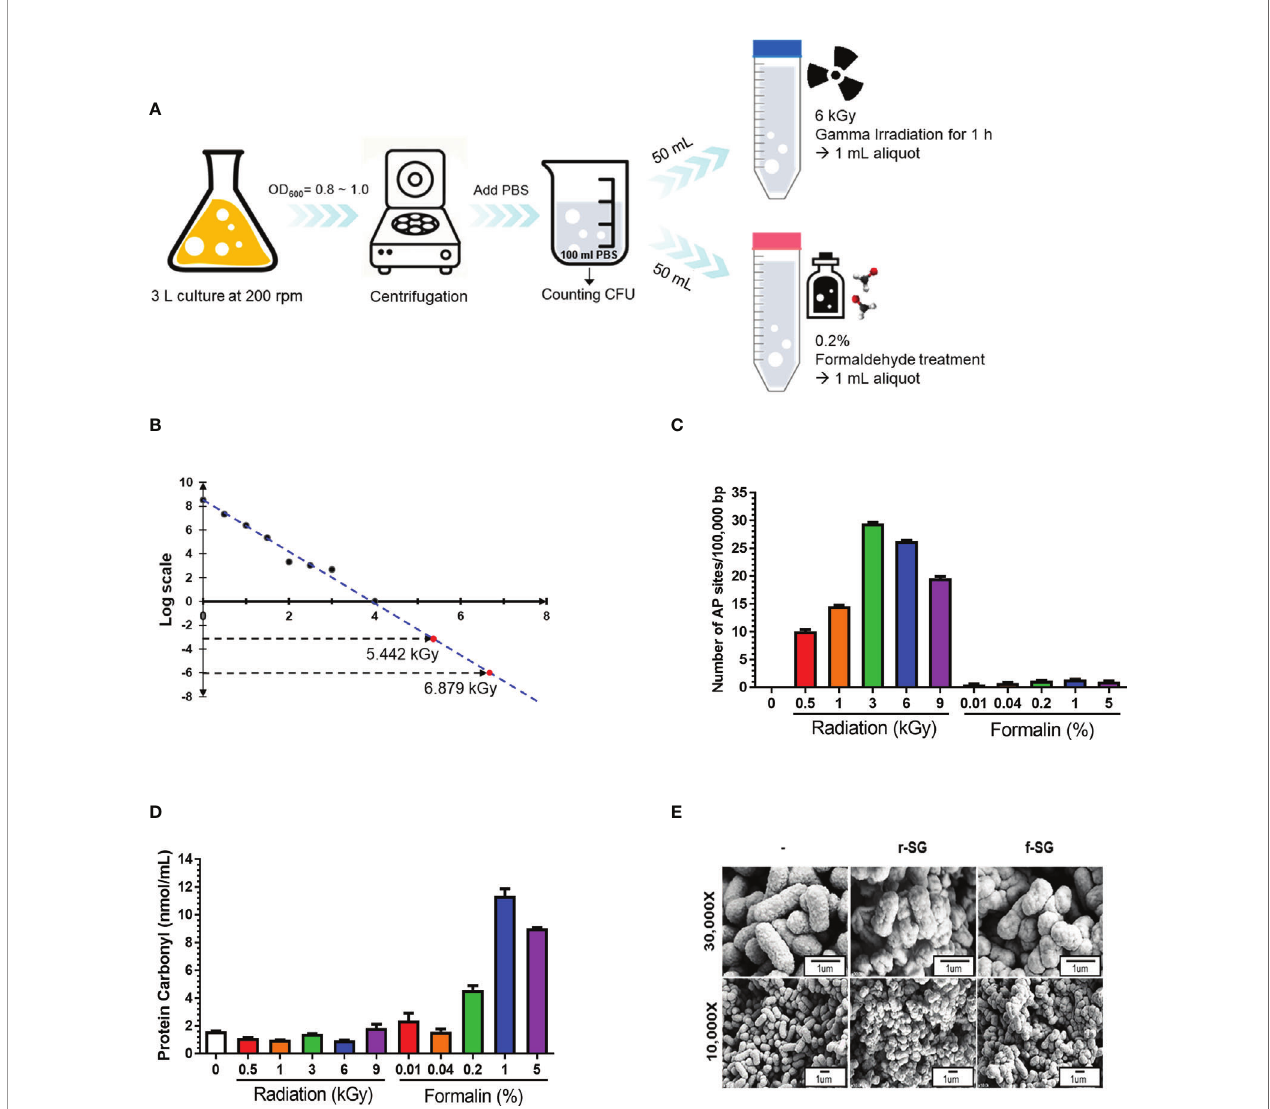
FIGURE 1 | Production and characterization of inactivated SG vaccines. (A) Schematic procedure for r-SG and f-SG vaccine production. (B) Radiation-inactivated vaccine was produced according to the ‘ Sterility Assurance Level (SAL). ’ SG was harvested and re-suspended in PBS and irradiated with the indicated dose of gamma radiation ( 60 Co gamma-ray source) and plated on LB agar to count the number of surviving bacteria. No SG was detected in samples irradiated with doses of gamma radiation >3 kGy. (C) Measurement of single strand chromosomal DNA breaks and (D) bacterial protein carbonylation after radiation- or formalin- inactivation. (E) The surface structure of SG, r-SG, and f-SG visualized by scanning electron